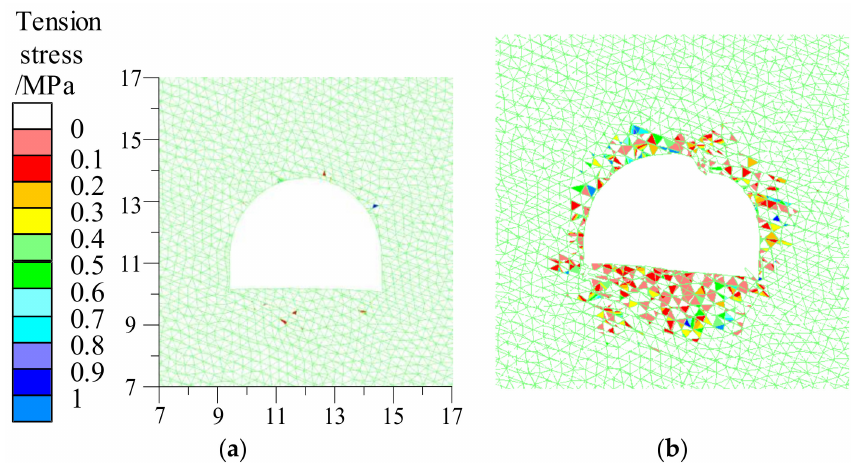
Figure 18. Tension stress evolution characters in the roadway surrounding rock during the excavation unloading process: ( a ) unloading stage 9; ( b ) unloading stage